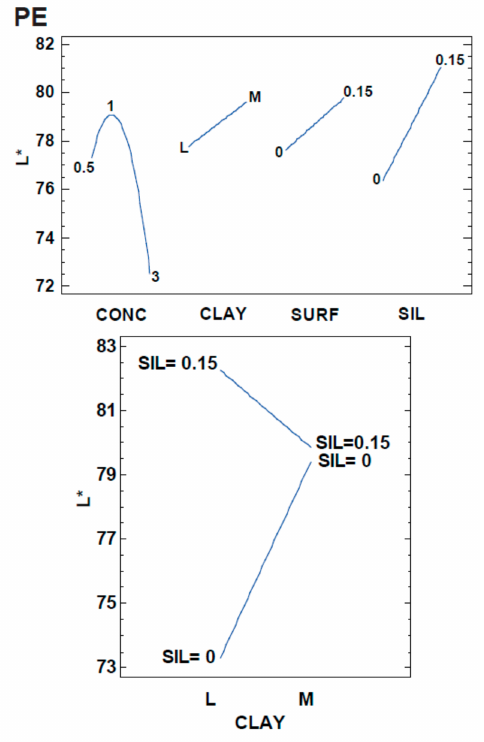
Figure 9. Main effects and interactions plots from the L* response in the PC